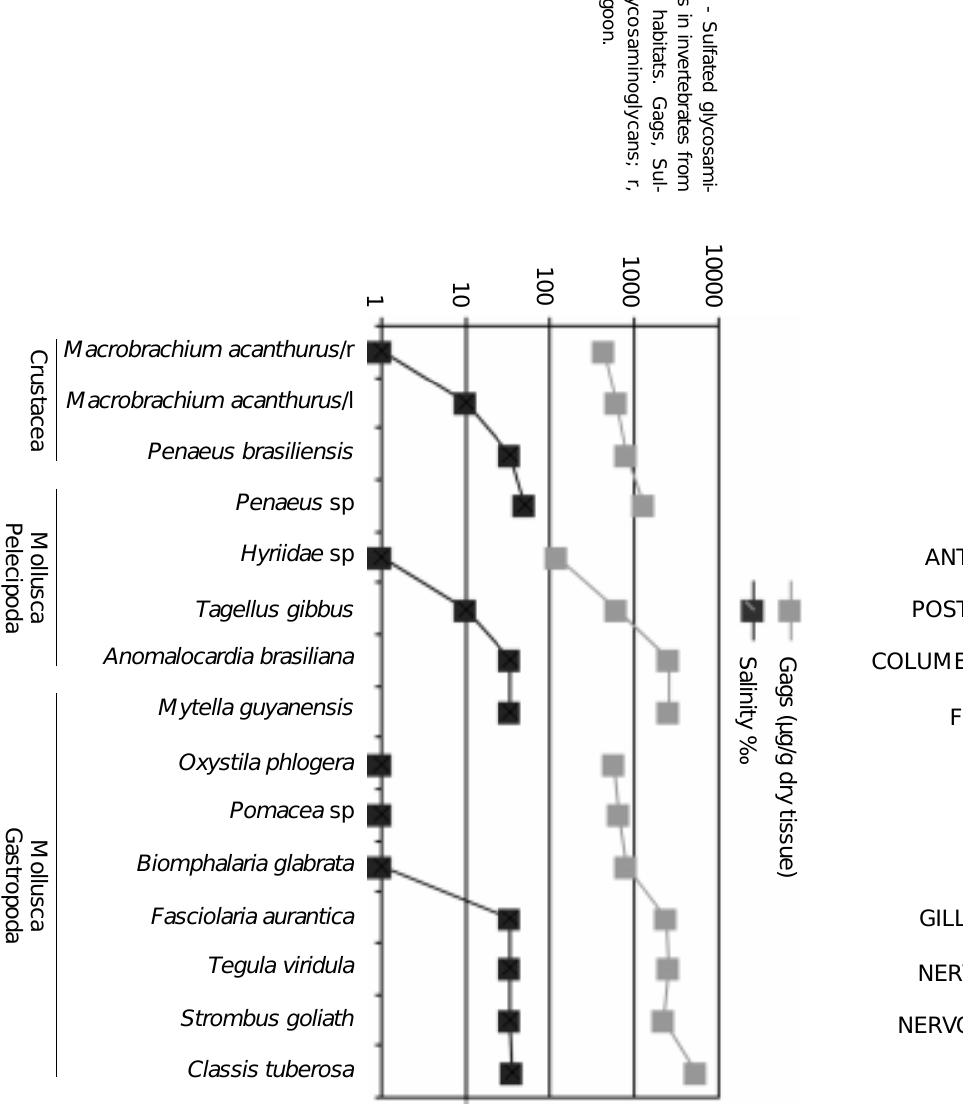
PHARYNX STOMACH INTESTINE ANT. DIG. GLAND POST. DIG.